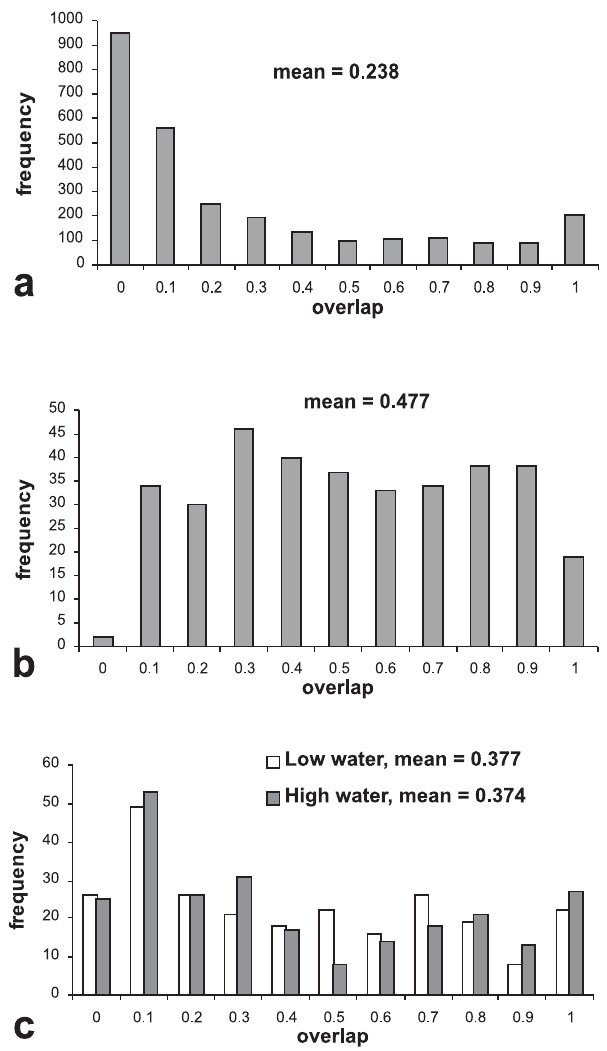
Fig. 3. Distribution of overlaps values between diets of fish species inhabiting a floodplain lake (lago do Rei) in Central Amazonia. a: whole community all seasons (74 species); b: generalist species all seasons (27 species); and c: seasonal differences (23